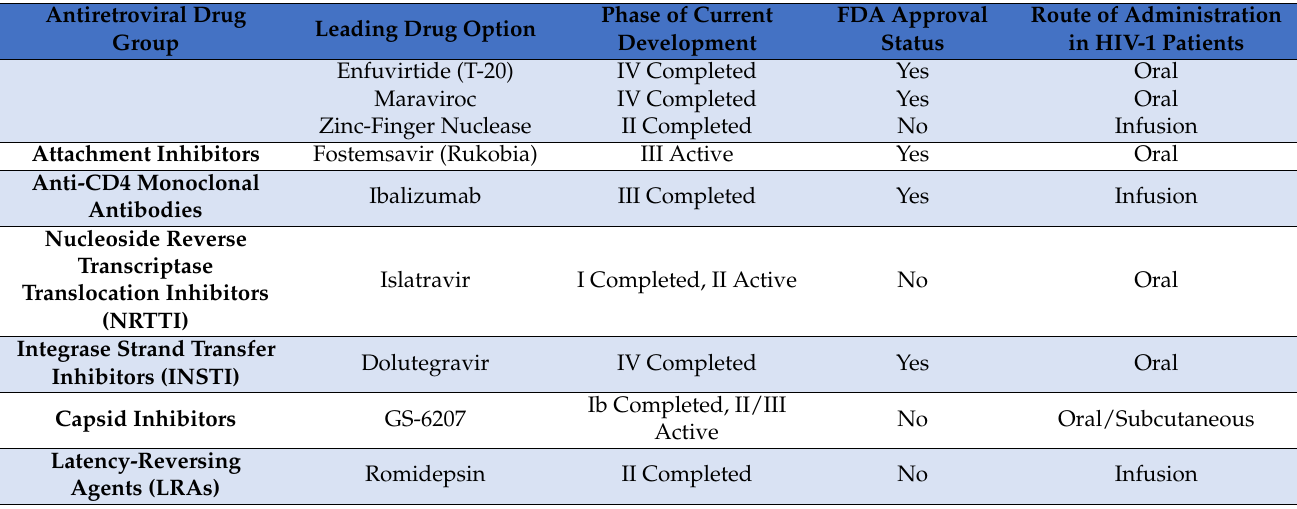
Table 1. Leading drug options among anti-HIV groups of drugs. Information was retrieved from the NIH US National Library of Medicine (https://www.clinicaltrials.gov/ct2/home accessed on 4 June 2021). Antiretroviral